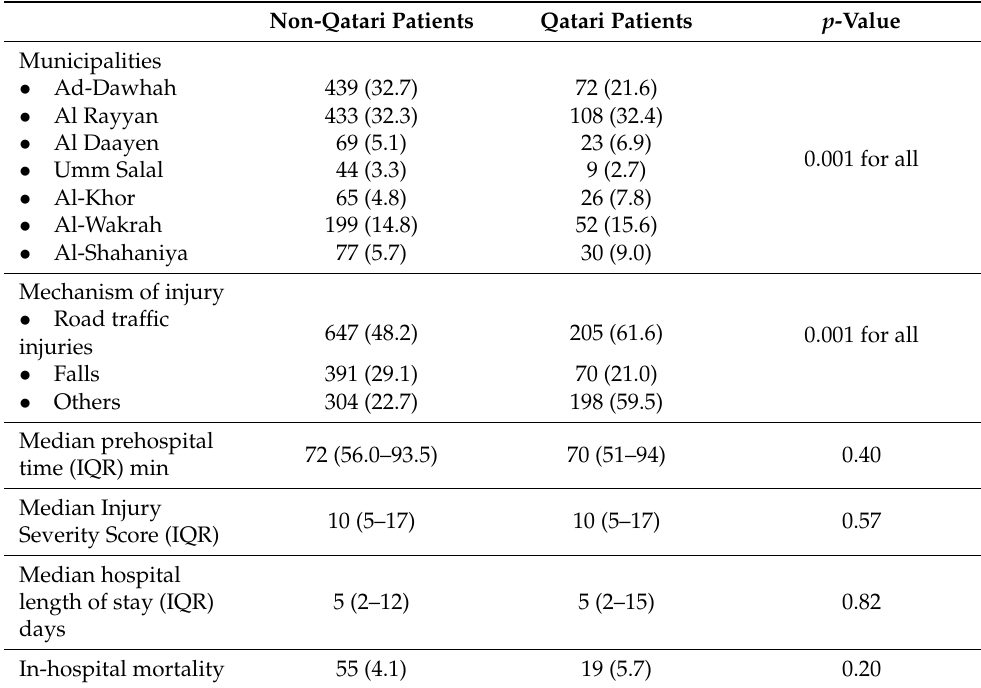
Table 2. Comparative analysis between non-Qatari and Qatari